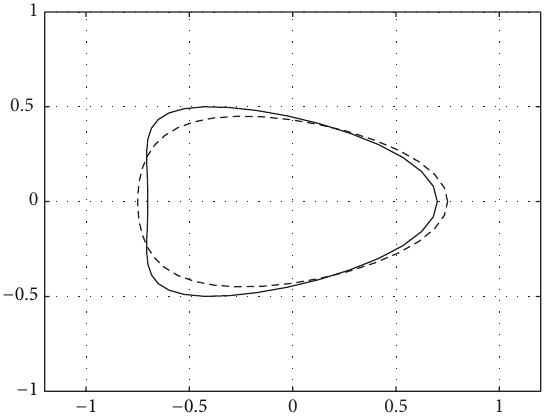
Figure 6: Case 2: 𝑡 = 0.30 , reconstruction of a cone-shaped